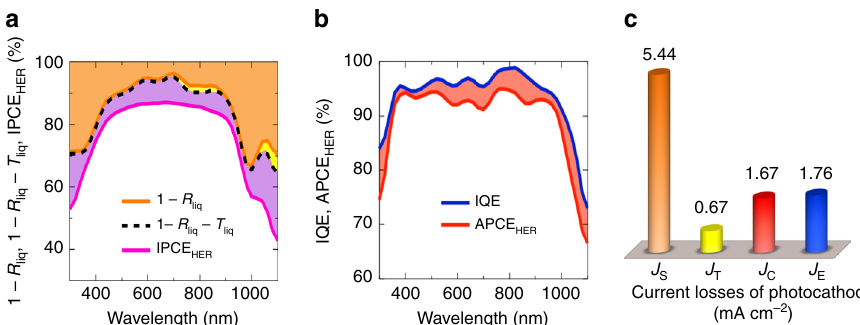
Fig. 3 Comprehensive analysis of the current losses by a unit BBJ photocathode for HER at pH 0. a Surface absorptance/re fl ectance/transmittance spectra and IPCE for HER. For the sake of clarity, the loss sources of J S and J T are shown by the area colored with orange and yellow, respectively. J Int is depicted with the color purple. b The IQE and APCE HER spectra, in which J C is depicted with the color red. c Summarized current losses obtained from a and b . The J Opt = J S + J T , and the J Int = J E + J